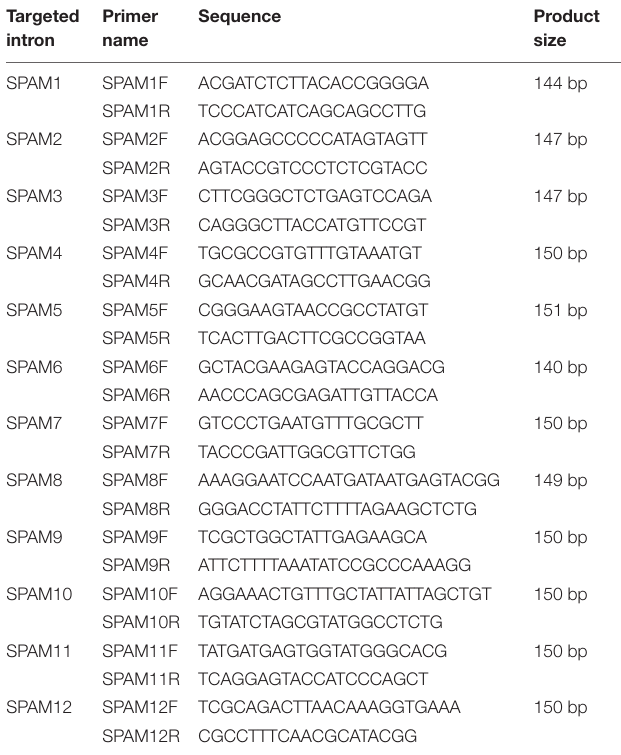
TABLE 2 | Primers used for PCR detection of mobile mitochondrial elements